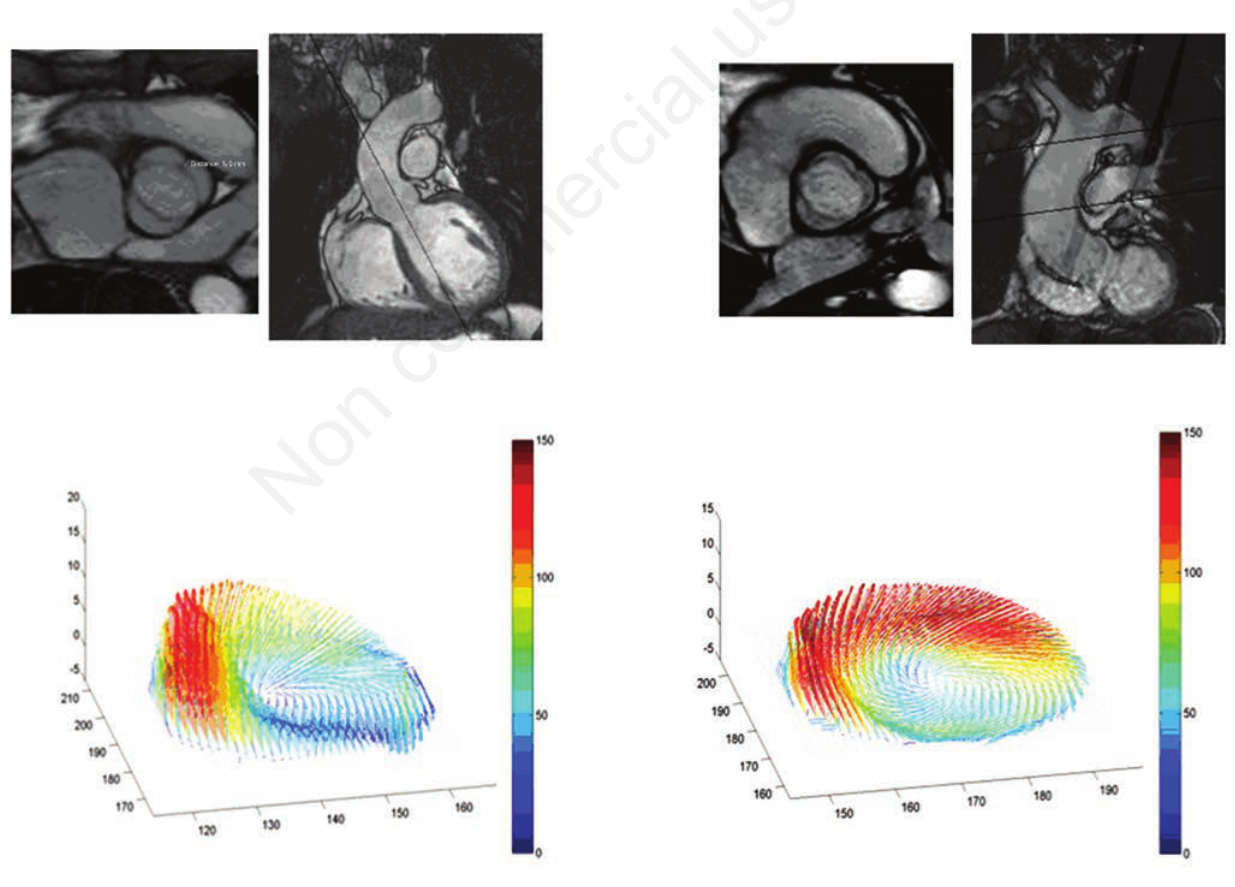
Figure 1. Patient-specific computational fluid dynamics. Comparison of peak systolic flow velocity vectors in a cross-section at the level of the sino-tubular junction in two bicuspid aortic valve (BAV) patients with echocardiographically normofunctional BAV with left- right type of fusion and non-dilated ascending aorta: marked eccentric flow is demonstrated in one, an helical pattern in the other. (Courtesy of Prof. Alberto Redaelli, PhD and Emiliano Votta, PhD, Politecnico di Milano, Milan,